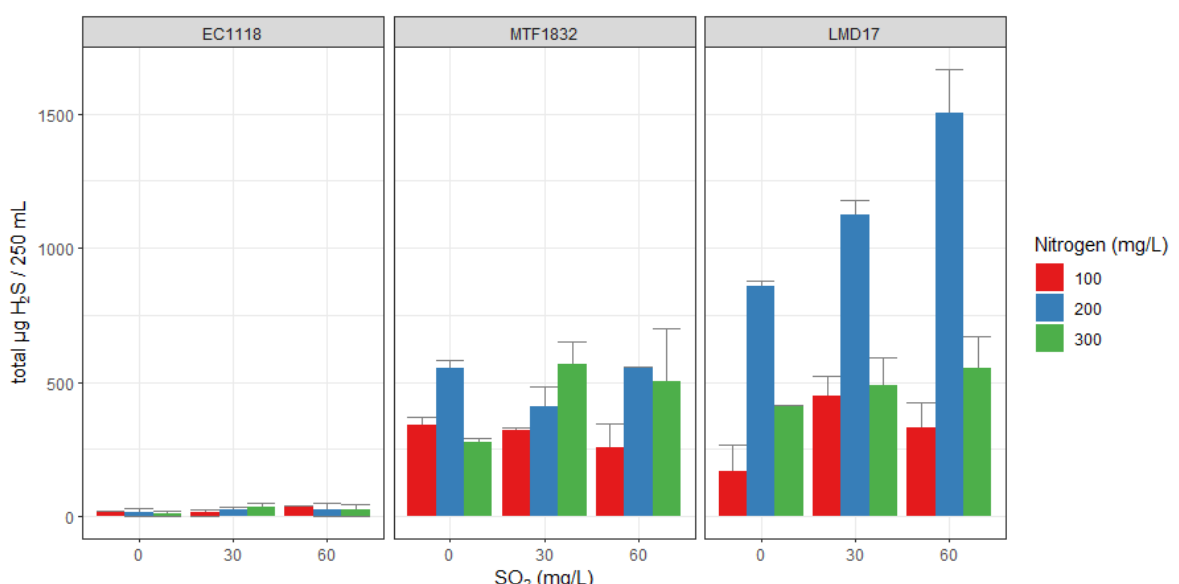
Figure 7. Total H 2 S production in presence of different assimilable nitrogen (colors) and sulfur dioxide ( x axis) content for each strain.